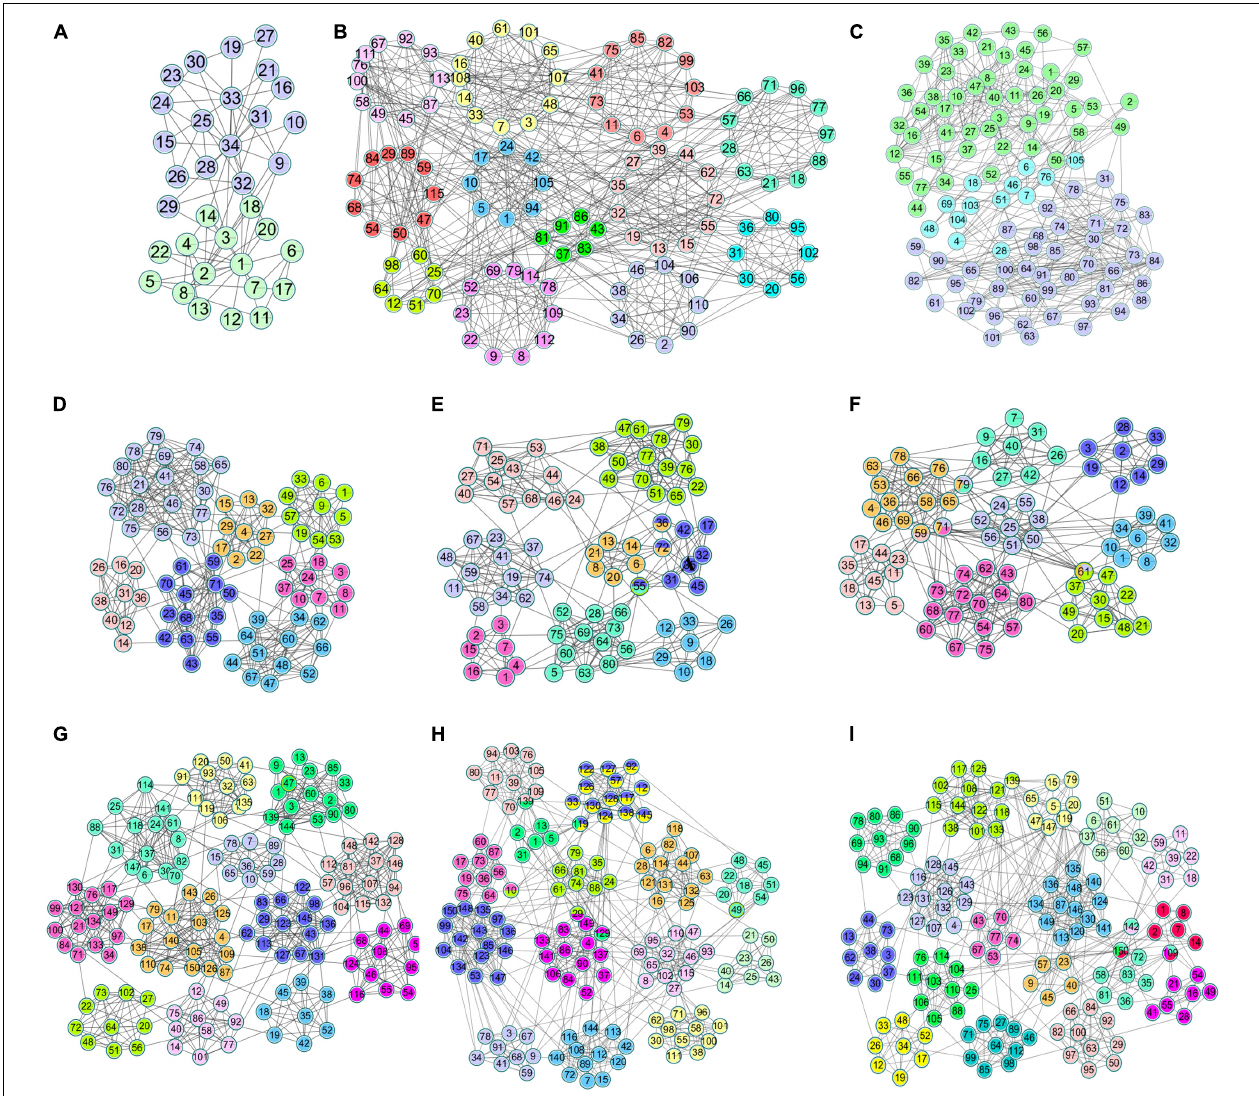
FIGURE 3 | The visualization of standard networks and LFR networks. Standard networks (A) Karate network, (B) Football network, (C) Polbooks network; LFR networks: (D) LFR1 network, (E) LFR2 network, (F) LFR3 network, (G) LFR4 network, (H) LFR5 network, (I) LFR6